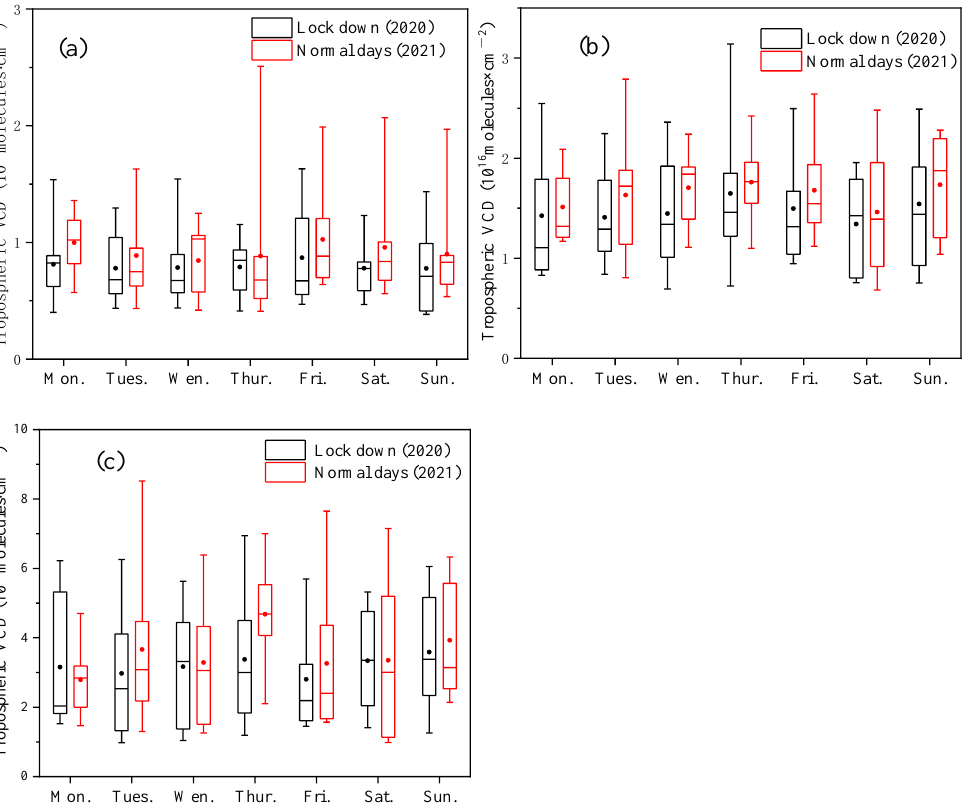
Figure 5. Weekly cycles of ( a ) NO 2 , ( b ) HCHO and ( c ) SO 2 VCDs observed over Huaibei during the lockdown period and normal days.